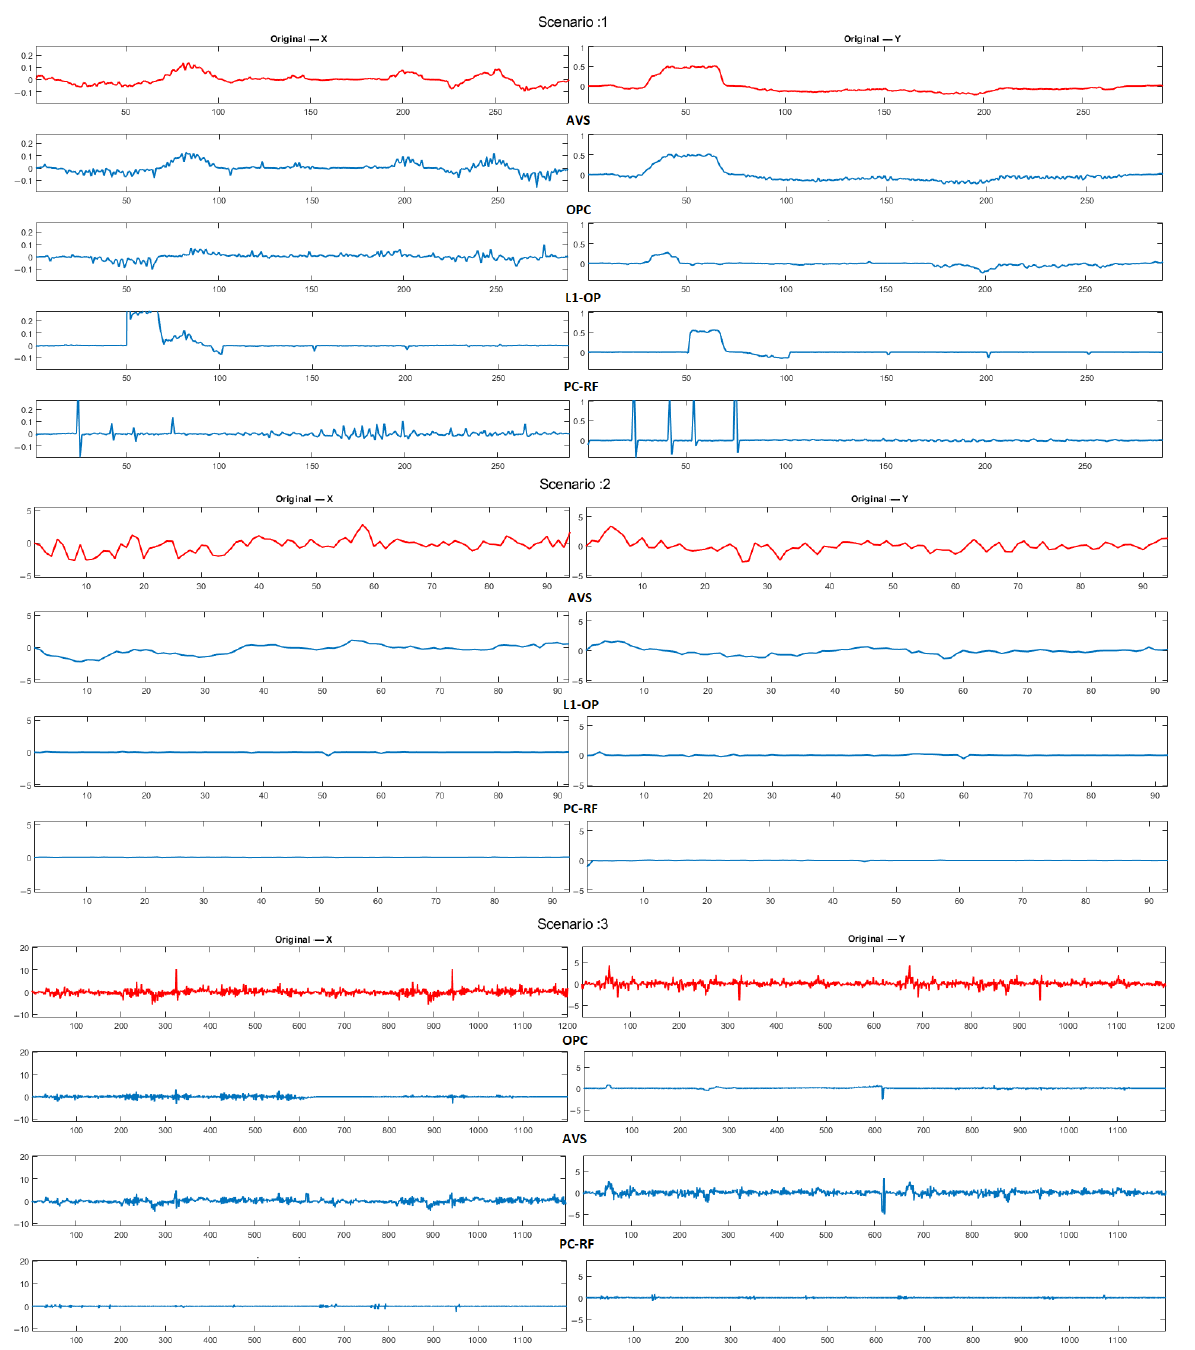
Figure 7. The figure shows the x and y global trajectory of the first, second, and third scenarios. The global trajectory demonstrates the ability of stabilization algorithm to remove the camera’s motions. The first and second scenario involves the camera’s motions and the third scenario involves the camera’s motion and moving objects in the